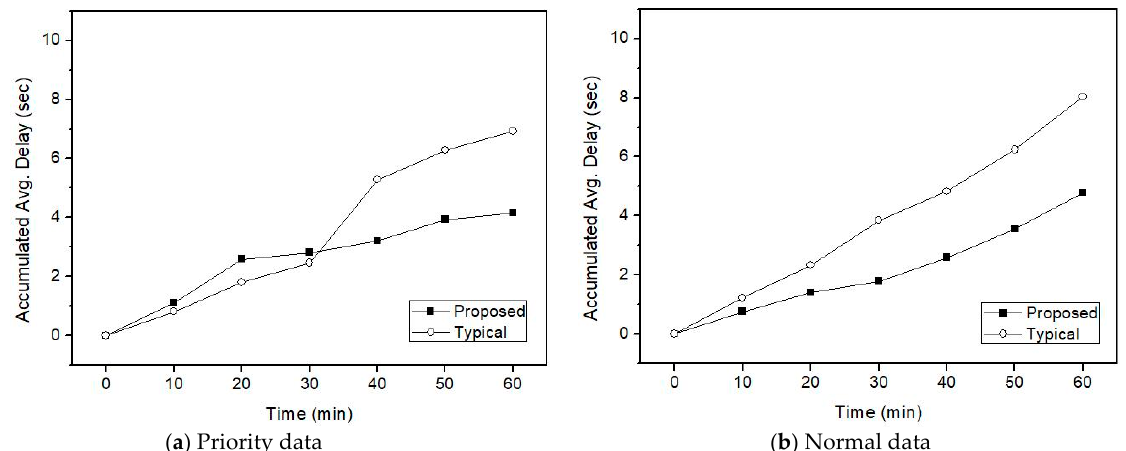
Figure 10. Transmission delay when p is 0.6 and IoV high ‐ priority is 30%.